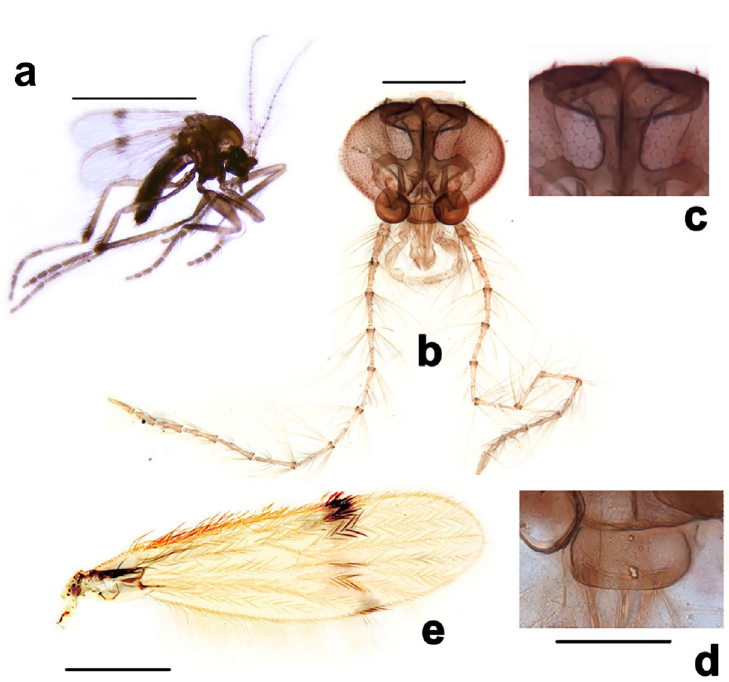
Fig. 3. Microphotography of Corethrella cabocla Feijó, Belchior, Marialva & Pessoa sp. nov. ♀, holotype (ILMD 0001 -45). a . Habitus. b . Head. c . Head with coronal suture elongate. d . Clypeus. e . Wing. Scale bars: a = 1 mm; b = 100 μm; c–d = 50 μm; e = 200 μm.